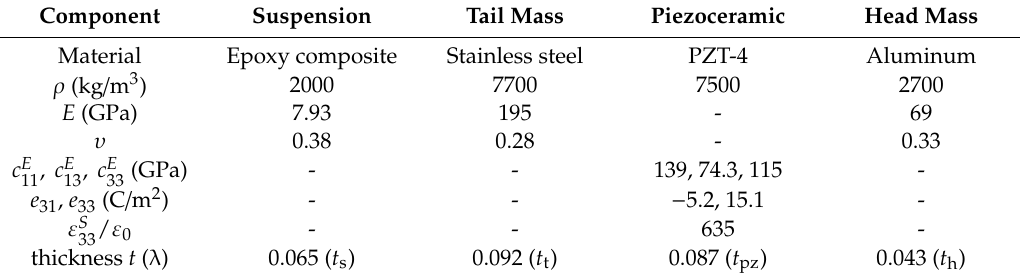
Figure 2. A finite element model (2-D axis-symmetric model) of the rear-mounted Tonpilz transducer. Table 1. Material and structural properties of the finite element model. The parameters, ρ , E , υ , c E , e , and ε S denote density, Young’s modulus, Poisson’s ratio, short-circuit elastic stiffness constant, piezoelectric stress constant, and dielectric permittivity at constant strain, respectively.